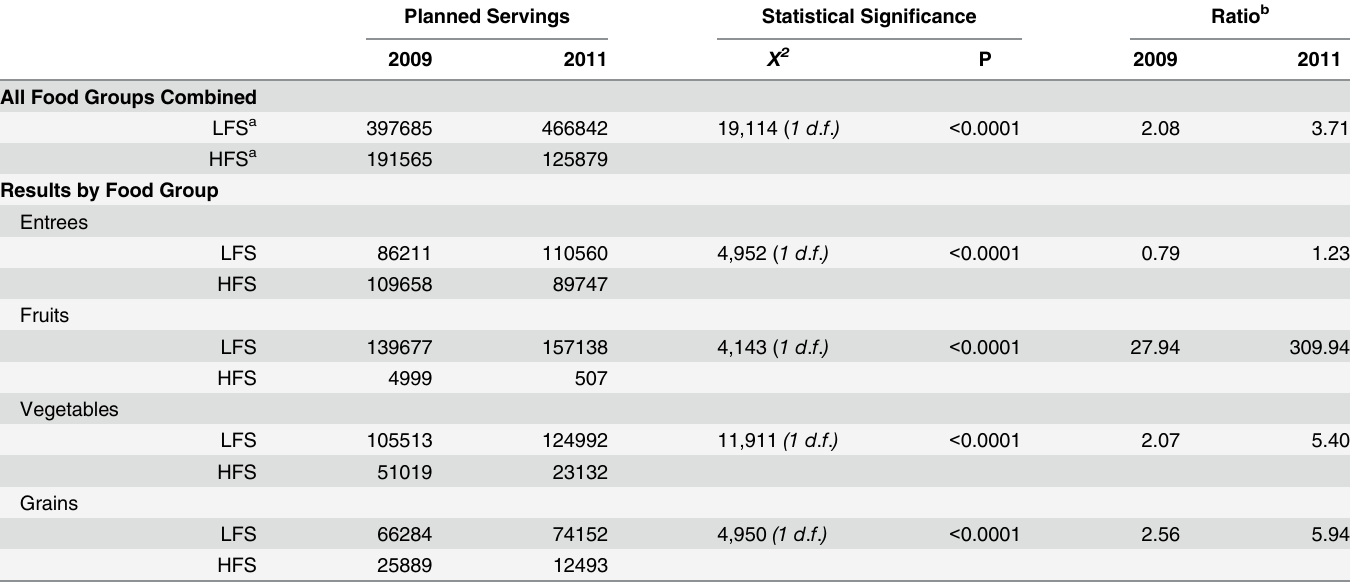
Table 2. Change in planned servings of “ Lower fat/less added sugar ” and “ Higher fat/more added sugar ” school lunch menu items for all districts combined, by food group, 2009 compared to 2011.